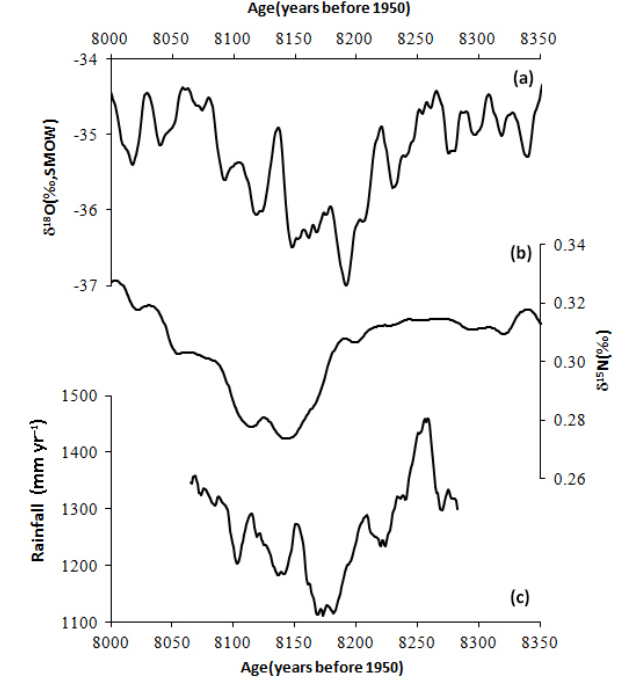
Figure 5. Records from Greenland ice core δ 18 O (Thomas et al., 2007) (a) , Greenland ice core δ 15 N (Kobashi et al., 2007) (b) , and the reconstructed annual rainfall from this study (c) during the 8.2kaBP event. Three sequences show a similar pattern indicat- ing the decrease in rainfall in southwest China was coupled with Greenland cooling during the 8.2kaBP